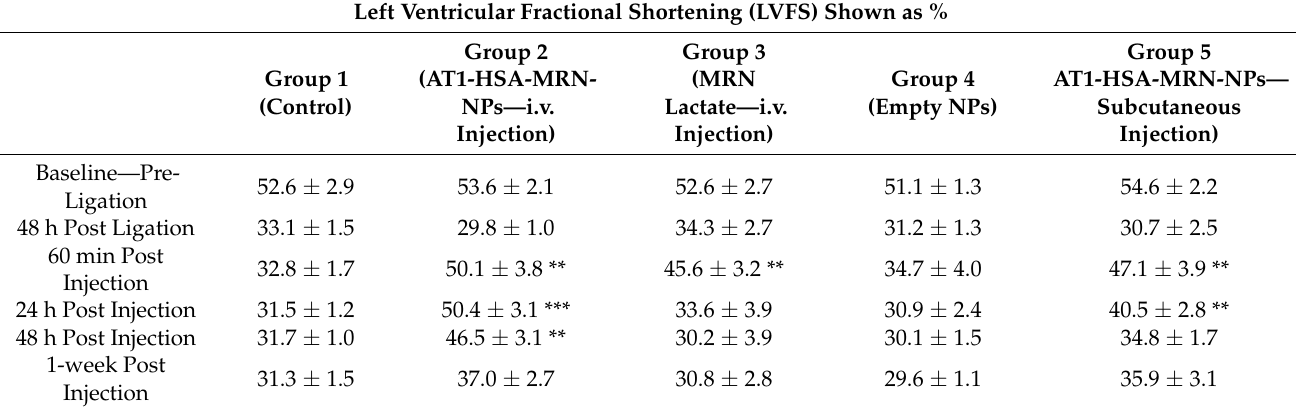
Table 5. Percentage LVFS measurements for Groups 1, 2, 3, 4, and 5 at various timepoints.